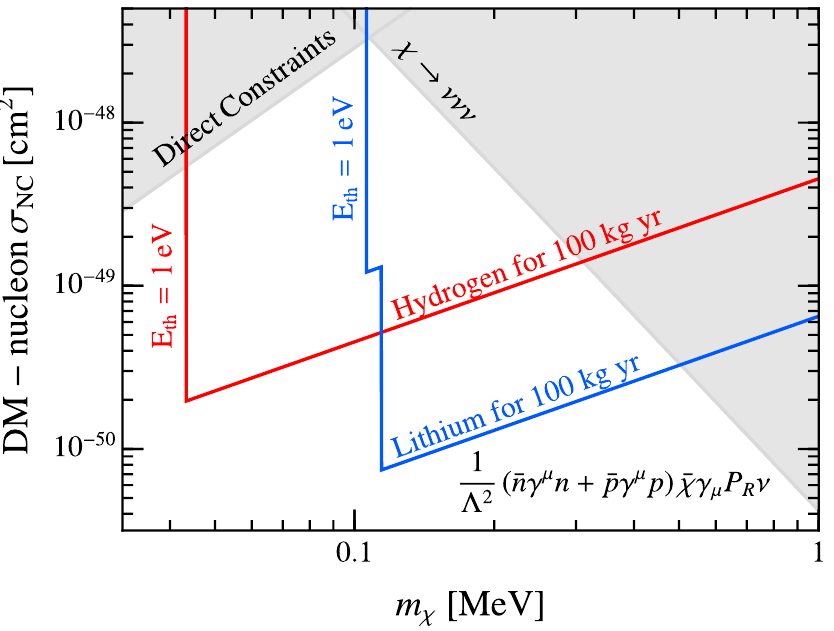
Figure 3 . Projected upper bound on (cid:27) NC as a function of m (cid:31) at future detectors with Hydrogen or Lithium targets. Bounds for both potential targets are shown assuming E th = 1 eV and M T T = 100 kg yr. Also shown in gray are the constraints from direct searches for Z 0 s and decays of (cid:31) for the benchmark UV completion with m Z 0 = 18 GeV, s (cid:18) the